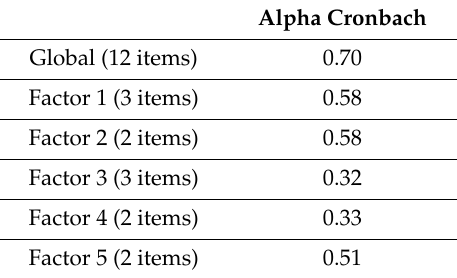
Table 4. Internal consistency reliability of the Attitude towards Pressure Ulcers (Spanish version).